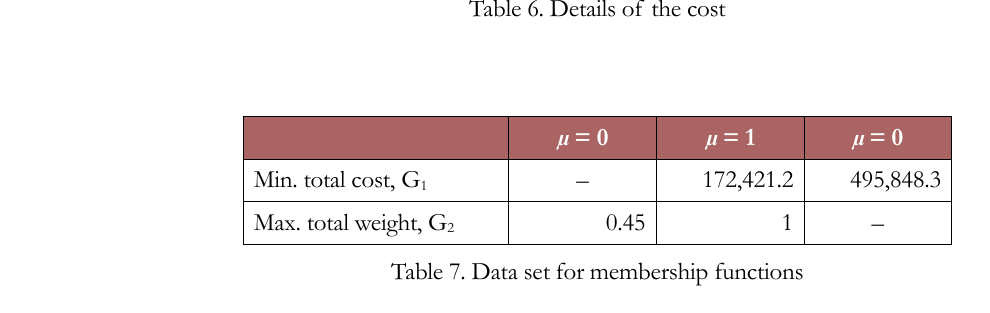
Table 6. Details of the cost